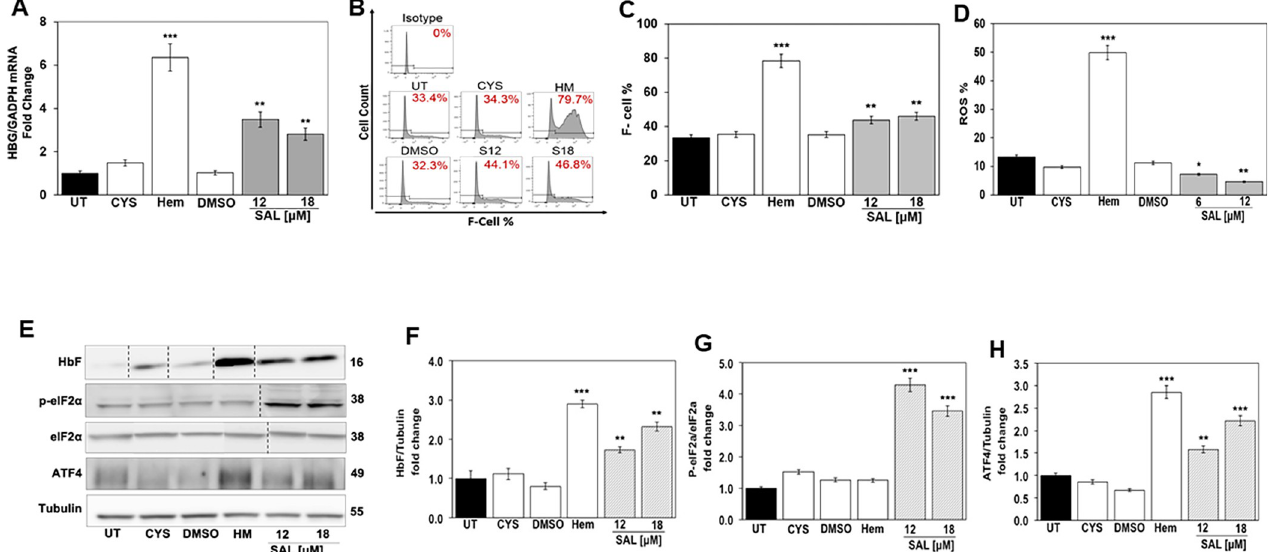
Fig 1. SAL increased HBG transcription and HbF synthesis. K562 cells were grown without treatment (UT) or treated with Cysteine 10 μ M (CYS; negative control), hemin 50 μ M (Hem; positive control) or salubrinal (SAL) 12 μ M and 18 μ M and vehicle control dimethyl sulfoxide (DMSO). Total RNA was isolated and whole cell lysates generated for RT-qPCR and Western blot analysis (See Material and Methods). All data are shown as the mean ± SEM (n = 6) and � p < 0.05; �� p < 0.01; ��� p < 0.001 was considered statistically significant. A) Shown in the bar graph is the HBG/GAPDH normalized mRNA levels generated by RT-qPCR analysis for each treatment conditions. B) Shown are flow cytometry histograms of K562 cells under the different conditions after staining with FITC-conjugated anti-HbF antibody . C) Shown in bar graph is the percentage of F-cells (F-cell %)-using FACS Diva software. D) Shown in the bar graph is the ROS percentage in the different conditions after staining with DCFDA (See Materials and Methods). E) Western blot analysis determined HbF, p-eIF2 α and ATF4 protein levels compared with tubulin (internal loading control); shown is a representative blot. The vertical black lines represent the change in band order to represent the data. Quantitative data generated by densitometry analysis measured expression levels of F) HbF normalized to tubulin, G) p-eIF2 α normalized to total eIF2 α , and H) ATF4 normalized to tubulin.